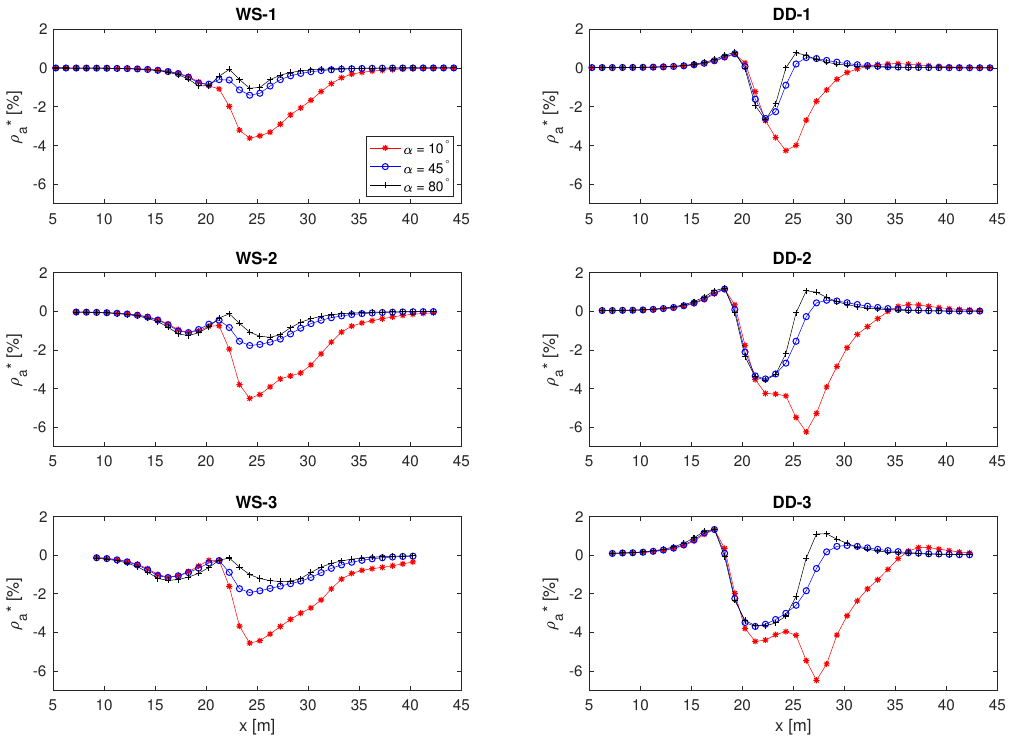
Figure 4. Apparent resistivity anomaly ρ ∗ a (in %) as a function of horizontal position for a single, 1-mm-aperture fracture having length (cid:96) = 10 m, electrical resistivity ρ f = 10 Ω · m, and hosted in bedrock having resistivity ρ b = 10,000 Ω · m. The fracture is covered by a 1 m thick layer of overburden, having resistivity ρ o = 1000 Ω · m. Anomalies for fracture angles of 10 ◦ , 45 ◦ , and 80 ◦ are shown, corresponding to Cases 4, 5, and 6 from Table 1, respectively. Measurement configurations are